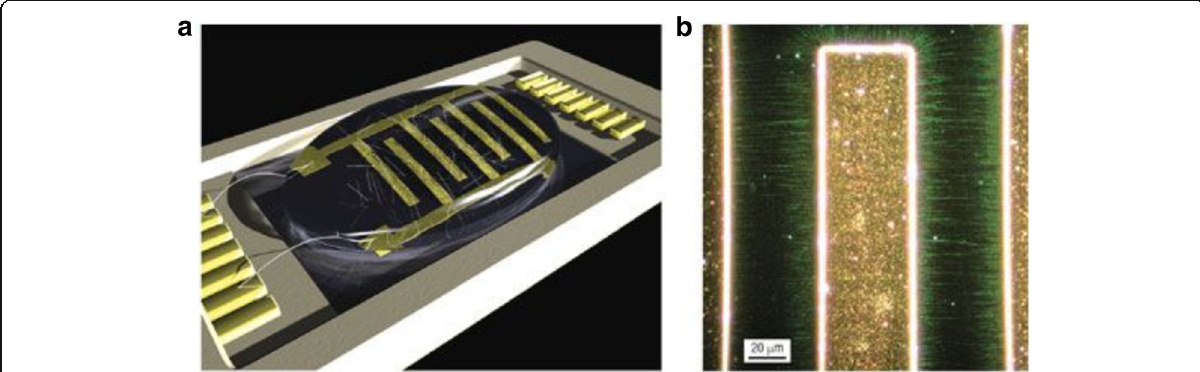
Fig. 23 a Schematic of the experimental setup of the dielectrophoresis of a SWCNT solution using a microelectrode array. The metallic tubes (in black) are deposited on the electrodes and semiconducting tubes are left in suspension (in white). Adapted from [182]. b Rayleigh scattered dark-field micrograph showing aligned SWCNTs (in green) and the corresponding polarized SWCNTs perpendicular to the electrodes. Adapted from